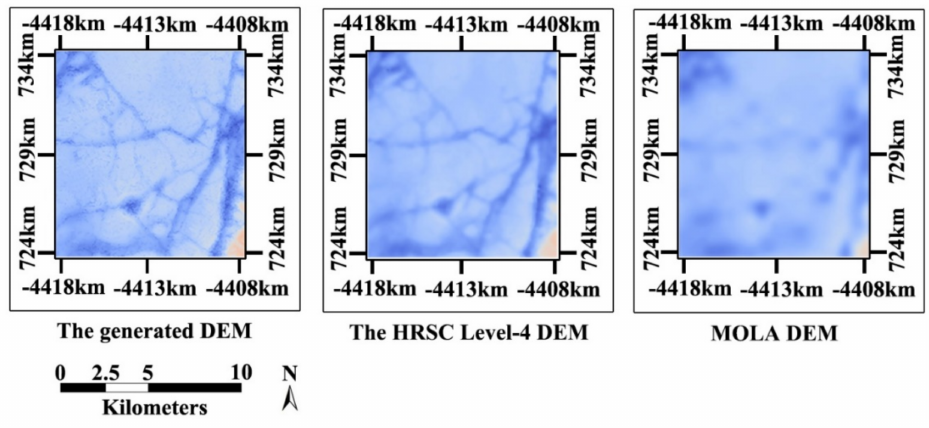
Figure 20. Visual comparison for the generated DEM, HRSC Level-4 DEM, and MOLA DEM.